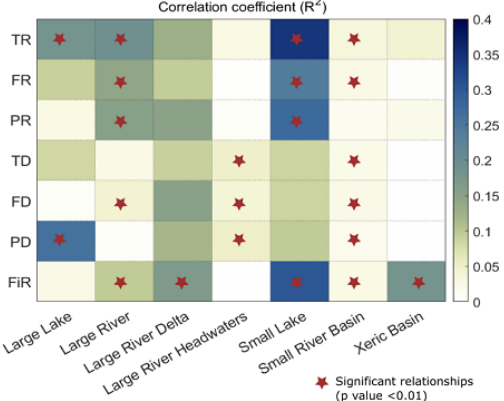
Figure 5. Coefficients of correlation ( R 2 ) for multivariate regres- sion between EF violation indicators and biodiversity indices. Each row represents one biodiversity indicator and each column repre- sents one G200